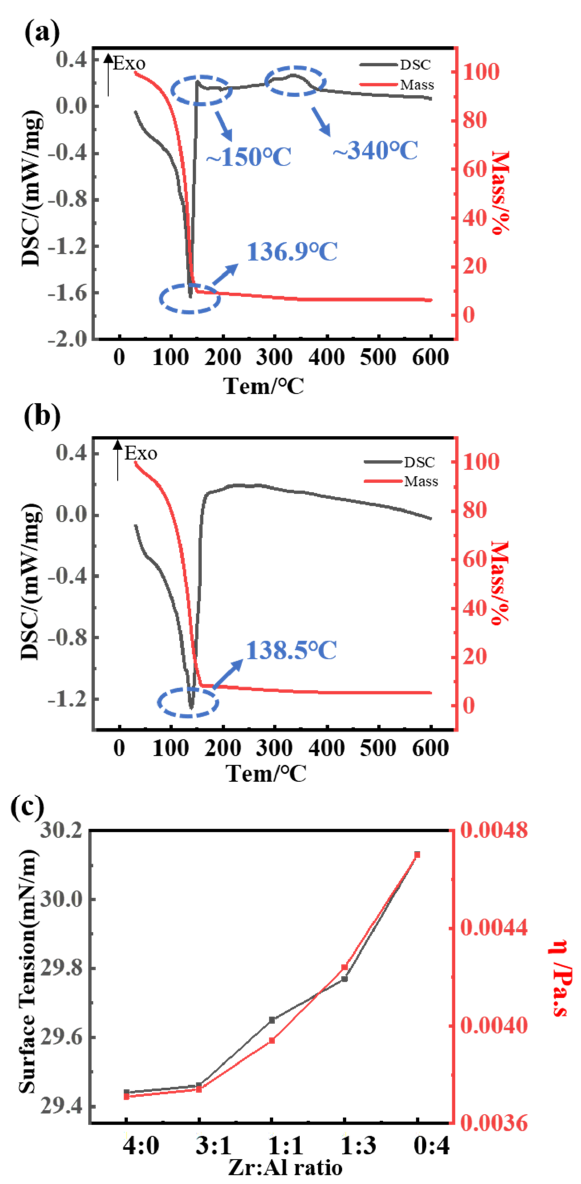
Figure 1. Thermal behavior of the ZAO precursor solution analyzed by thermogravimetry-differential scanning calorimetry (TG-DSC): ( a ) pure zirconia film; ( b ) pure alumina film; and ( c ) the surface tension and viscosity of the precursor with the various ratios.